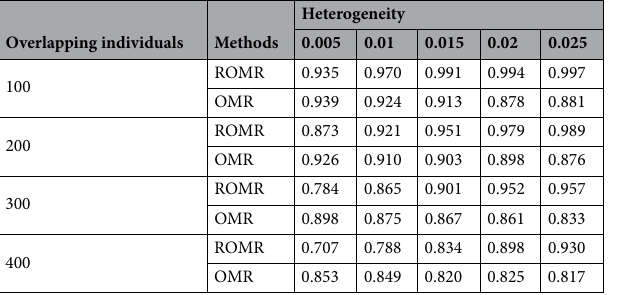
Overlapping individuals